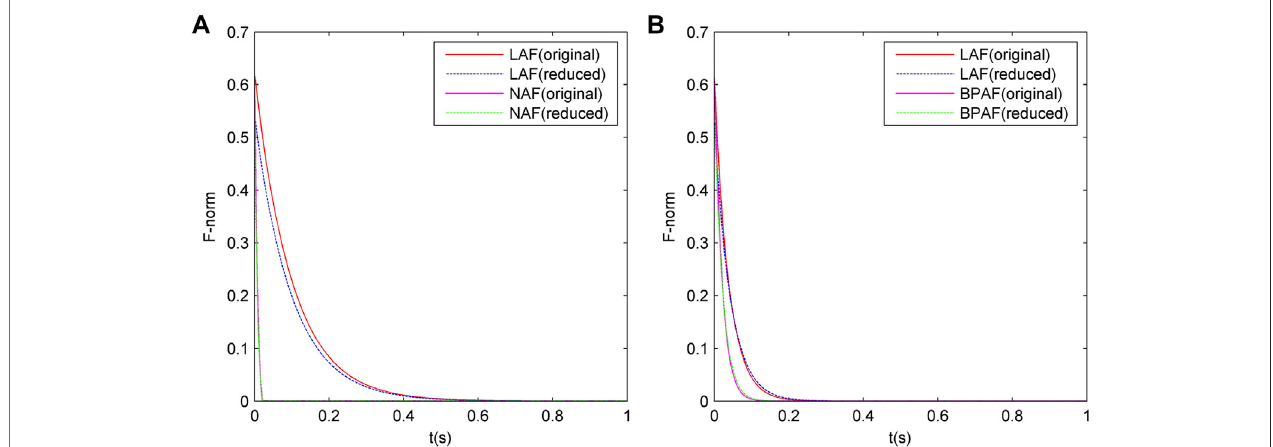
FIGURE 3 | Comparison of the convergence between the original-order and the reduced-order RNN models under Example 1. (A) is ZNN, (B) is GNN.